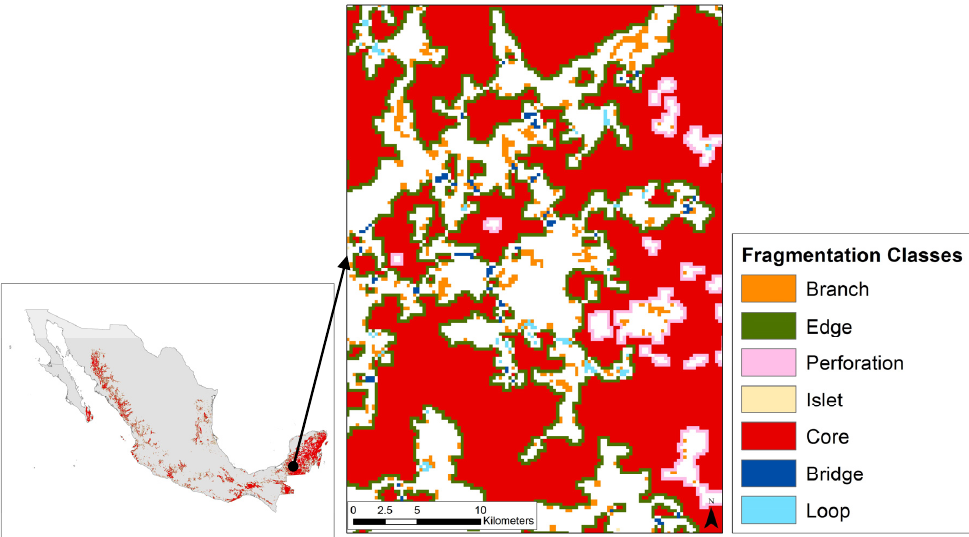
Figure 3. Sample of the map output of MSPA fragmentation classes generated with the intext parameter set to “Off” for an area of the tropical forests in 2002. set to “Off” for an area of the tropical forests in